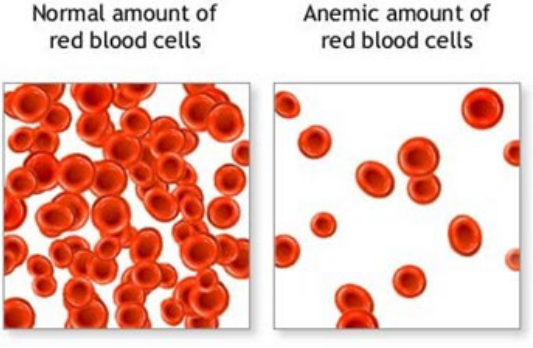
Figure 3. Amount of red blood cells in